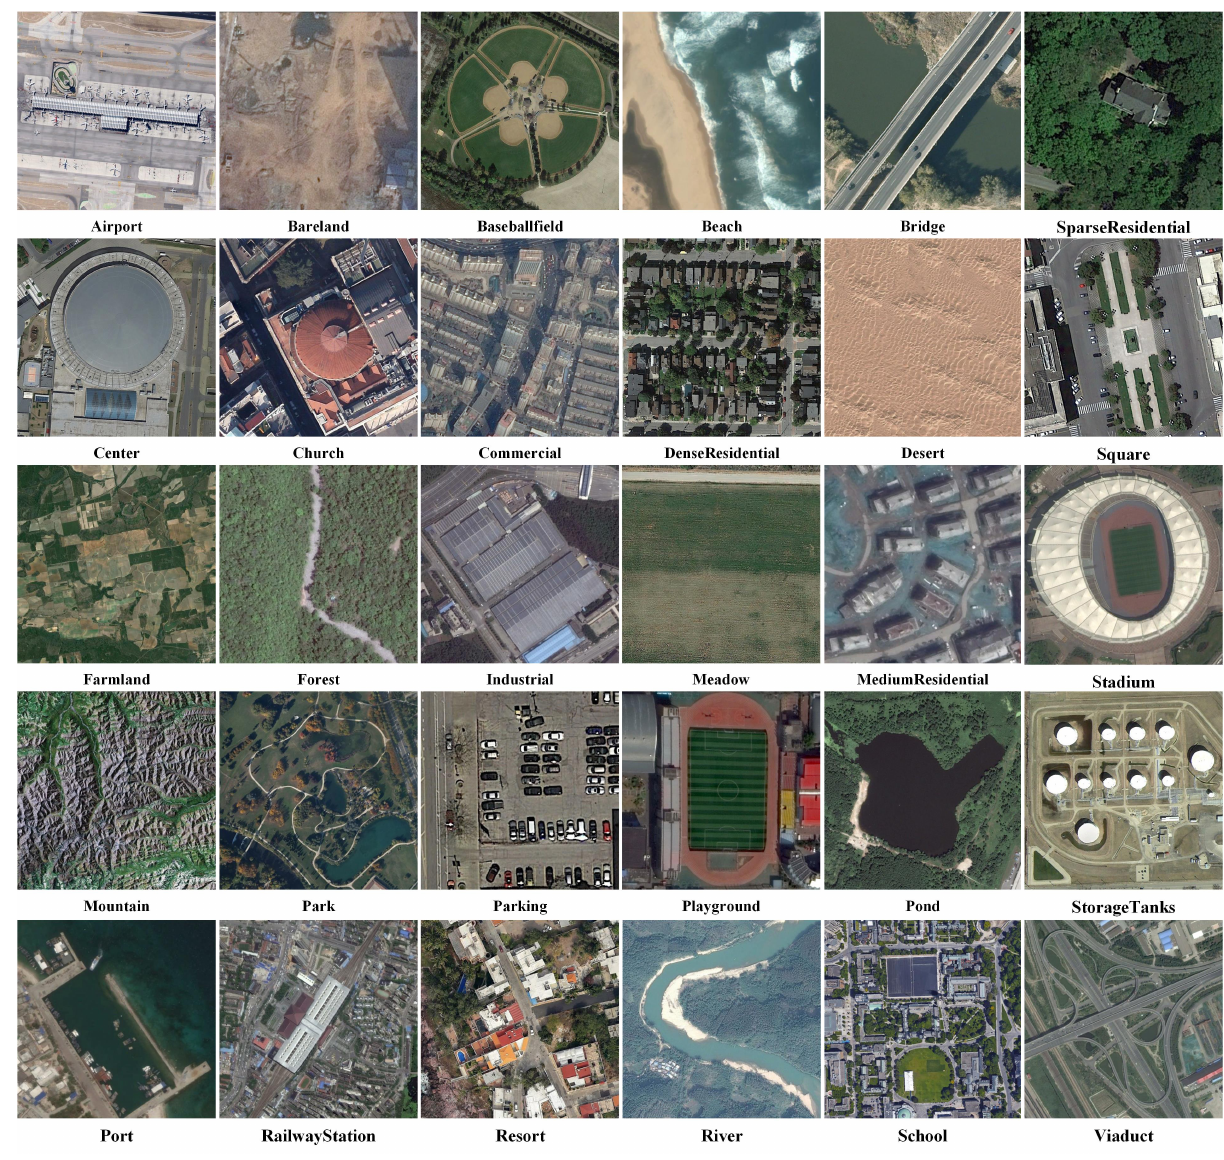
Figure 6. Sample of the AID